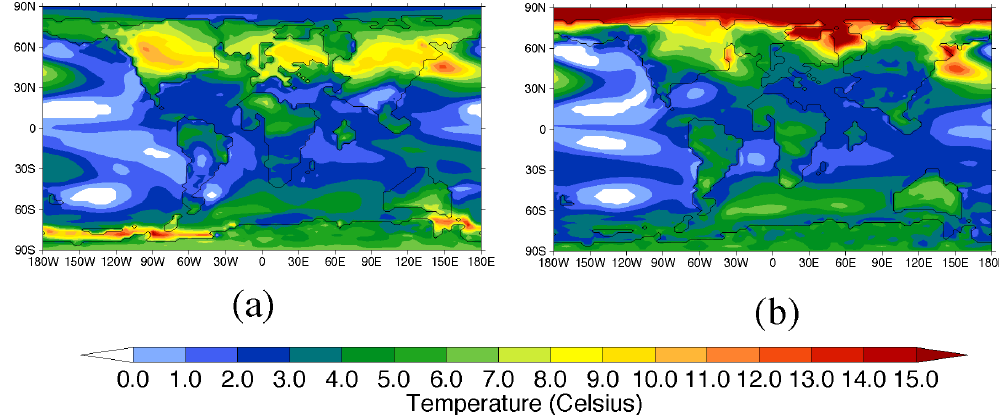
Fig. 11. Surface air temperature differences when CO 2 is doubled from 2 × to 4 × (i.e. 4 × FIXED − 2 × DYN) (a) in JJA and (b) in DJF. Only differences at the 95% confidence level are